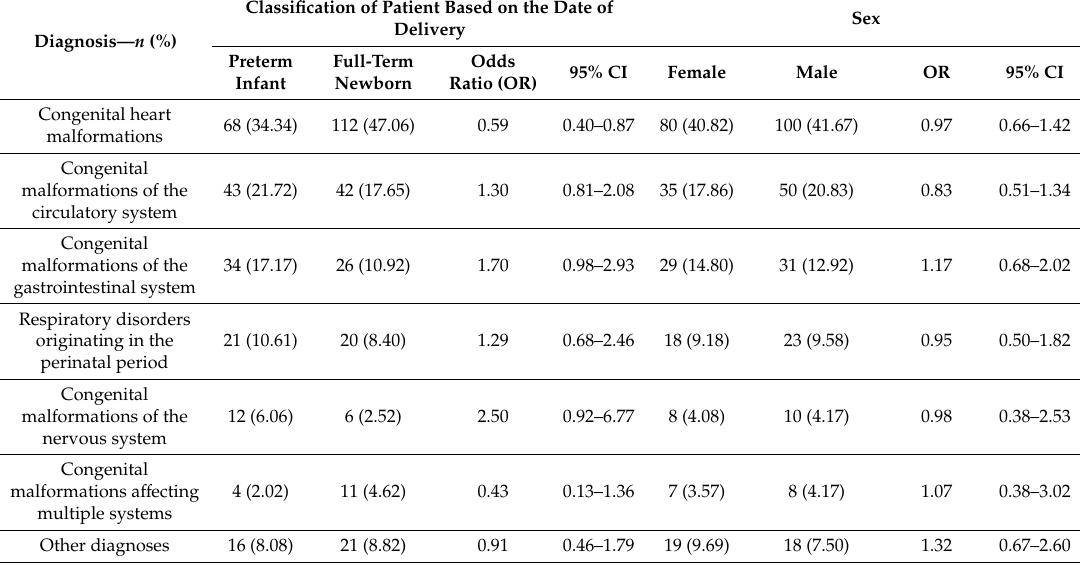
Table 4. The occurrence of congenital malformations in surveyed patients depending on patient classification based on the date of delivery and